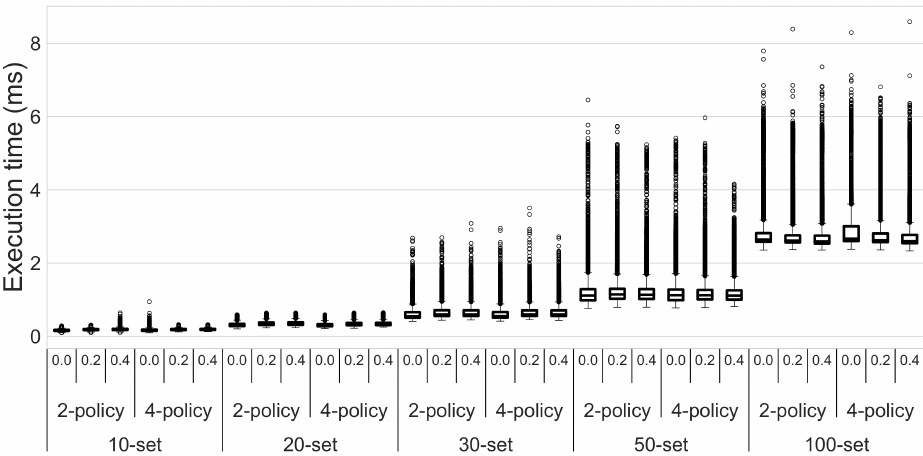
Figure 14. Execution time of our matching algorithm according to several different parameters. The error rate has almost no effect on the execution time, while it increases as expected with the number of elements in the generating set.